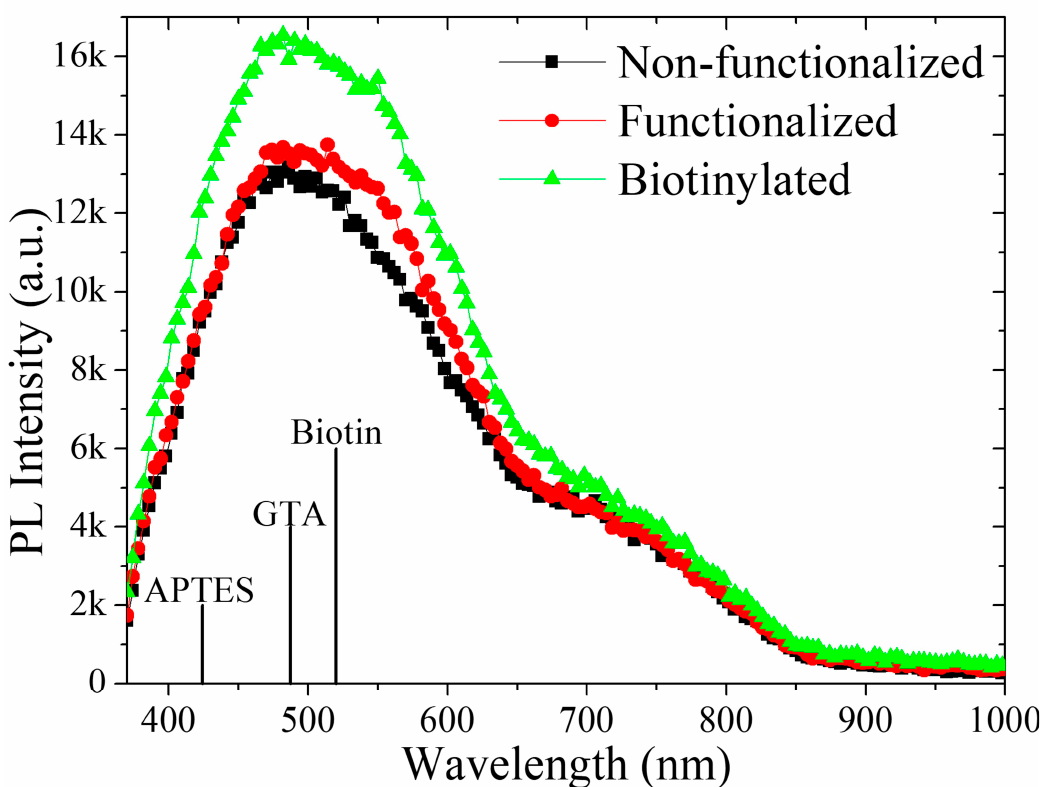
Figure 4. PL spectra for the Si 3 N 4 surface (black line), after functionalization (red line) and after biotinylation (green line). The peak wavelengths of PL emission of the APTES, GTA, and biotin molecules are indicated on the wavelength axis [30,31,34].